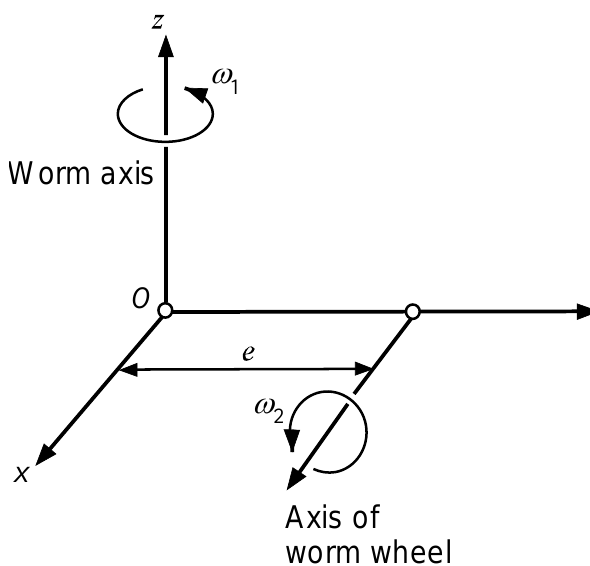
Figure 3. Relation between worm axis and axis of worm wheel.